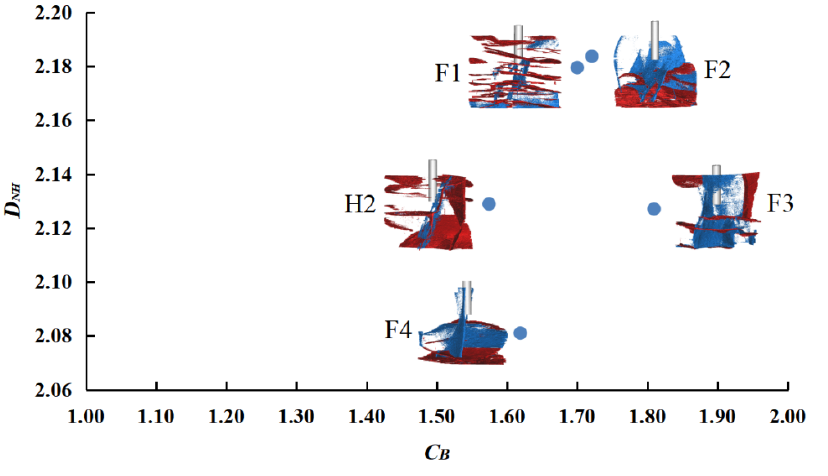
Figure 12. Distribution of fractal dimension ( D NH ) and topological parameters ( C B ) of fractures under different fluid viscosities.